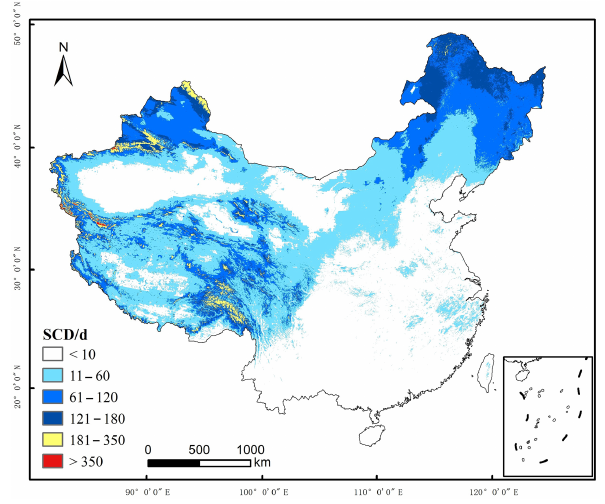
Figure 4. Spatial distribution of the average annual number of snow-covered days during 2001–2014 in